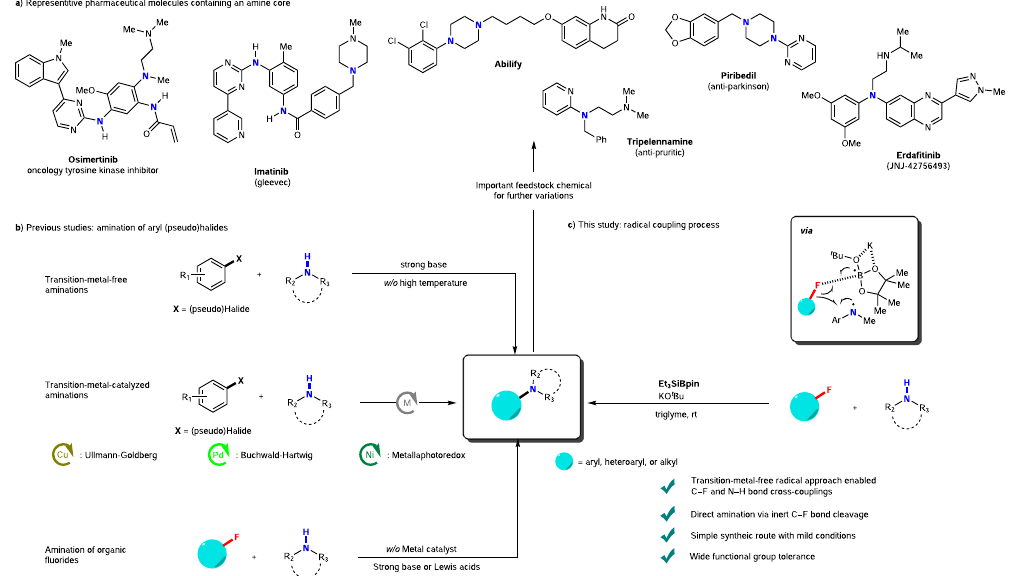
Fig. 1 | Cross-couplings and related reactions of aryl or alkyl halides with secondary amines. a Representative pharmaceutical molecules containing aryl and alkyl amines. b Previous studies. c This